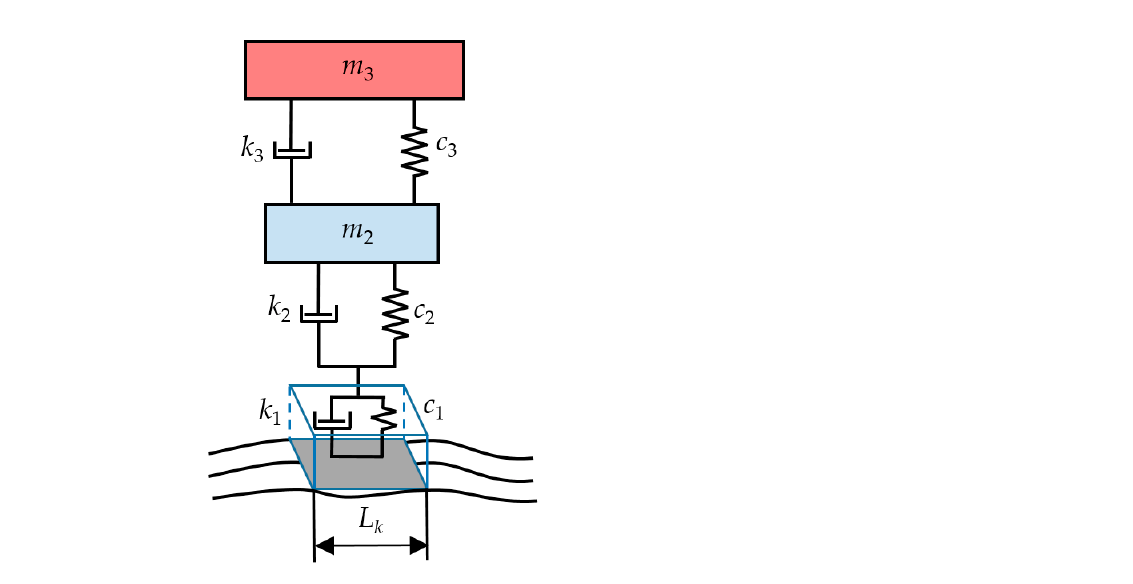
Figure 2. Quarter-car model: L k —tire-road contact length; m 1 , c 1 and k 1 —mass, stiffness, and damping ratio of the tire tread part; c 2 , k 2 —tire stiffness and damping ratio; c 3 , k 3 —suspension stiffness and damping ratio; m 2 —unsprung mass; m 3 —sprung mass.